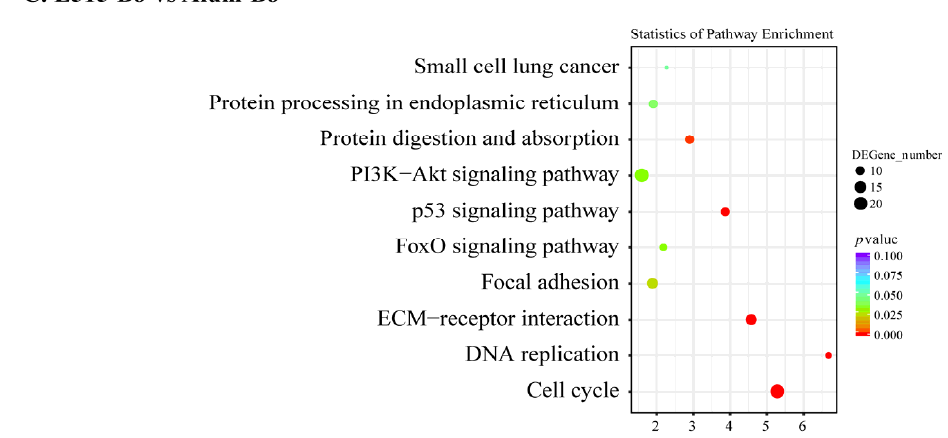
Figure 5. Kyoto Encyclopedia of Genes and Genomes (KEGG) pathway enrichment analysis of DEGs in two comparisons. ( A ) E515- Bb vs. Bb , ( B ) Alum- Bb vs. Bb , and ( C ) E515- Bb vs. Alum- Bb . The X-axis represents the value of the rich factor. The Y-axis represents the enrichment term of the pathway. The size of the dot represents the number of DEGs. The color represents p value.